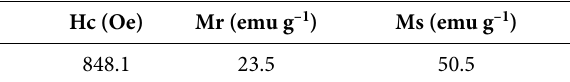
Table 1: VSM analysis of CFNC